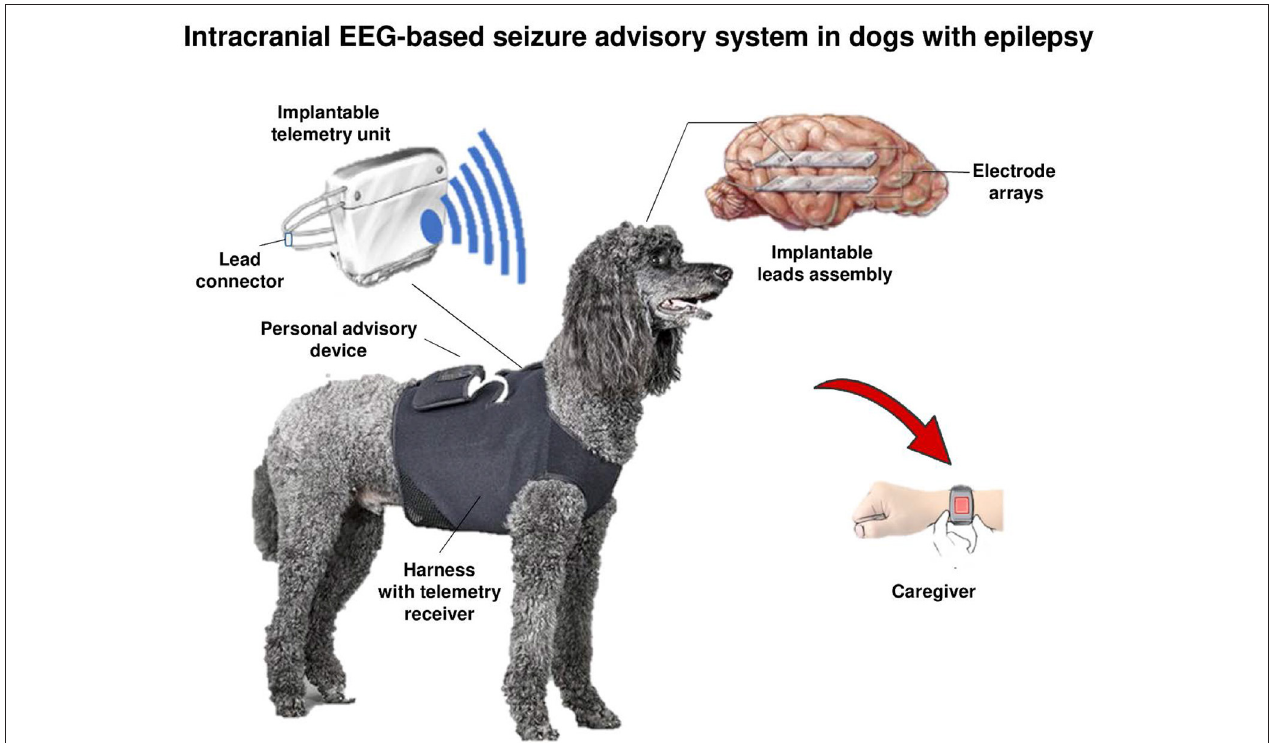
FIGURE 8 | Schematic of a dog with an implanted ambulatory NeuroVista Seizure Advisory System (SAS). The implantable device for recording and storing continuous iEEG includes: An Implantable Lead Assembly (ILA) placed in the subdural space, an Implantable Telemetry Unit (ITU), and a Personal Advisory Device (PAD). The ILA, which acquires 16 channels of iEEG, detects and relays electrical activity in the brain to the ITU. The ITU receives data from the implantable leads, predicts seizure activity using an algorithm, and sends a wireless alert to the PAD. The PAD sends a wireless alert to the caregiver, which may lead to accelerated intervention and administration of seizure-stopping medication (see text). All iEEG data are stored on a flash drive and uploaded weekly via the internet to a central data storage site. Modified from Coles et al. (